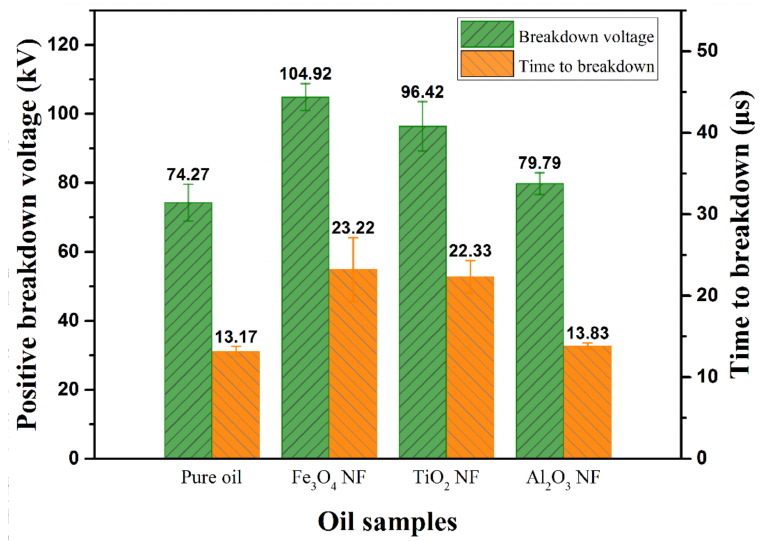
Figure 4. Positive breakdown strengths of pure oil and